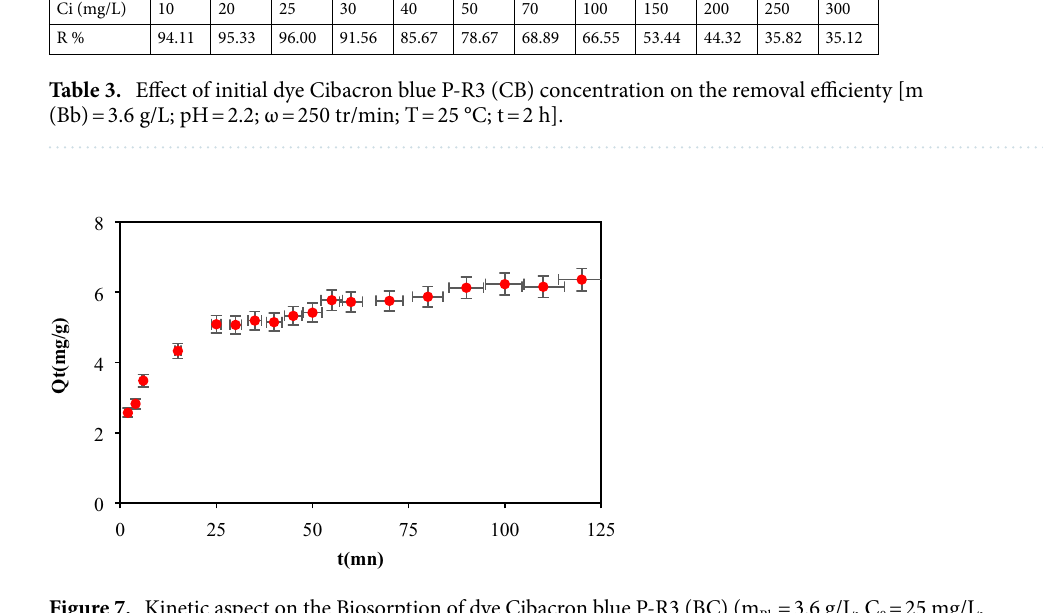
Figure 7. Kinetic aspect on the Biosorption of dye Cibacron blue P-R3 (BC) (m Bb = 3.6 g/L, C 0 = 25 mg/L, pH = 2.2, T = 25 °C, ω = 250 tr/min, t = 2